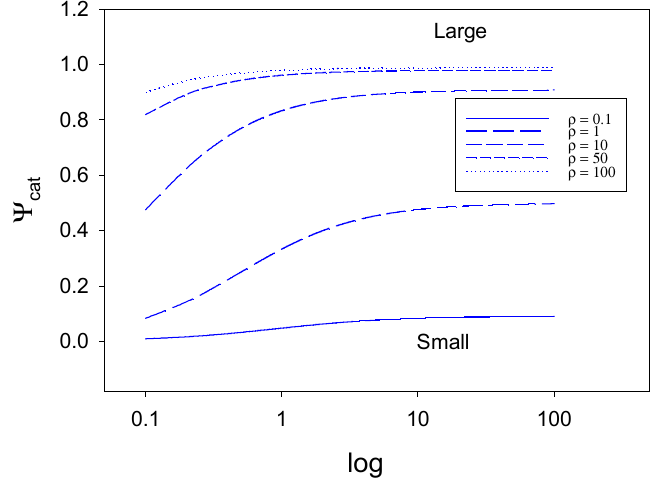
Figure 8. Variation of the normalized catalytic current with the parameter λ which compares the rate of the surface electron transfer to the rate of deactivation of the active species S*, according to the theoretical expression developed in eqn. 32 of the